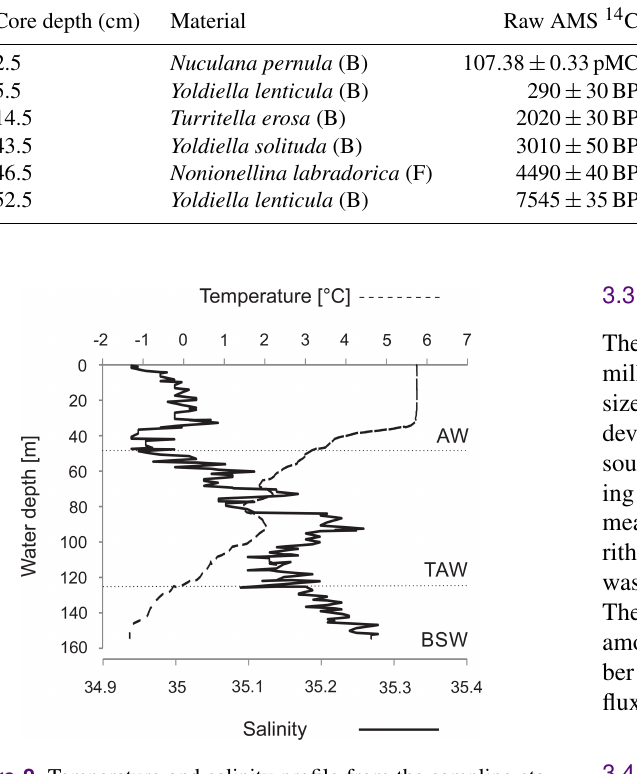
Figure 2. Temperature and salinity profile from the sampling sta- tion. Temperature is marked with a dashed line, and salinity is marked with a black line. Abbreviations: AW – Atlantic Water, TAW – transformed Atlantic Water, BSW – brine-enriched shelf